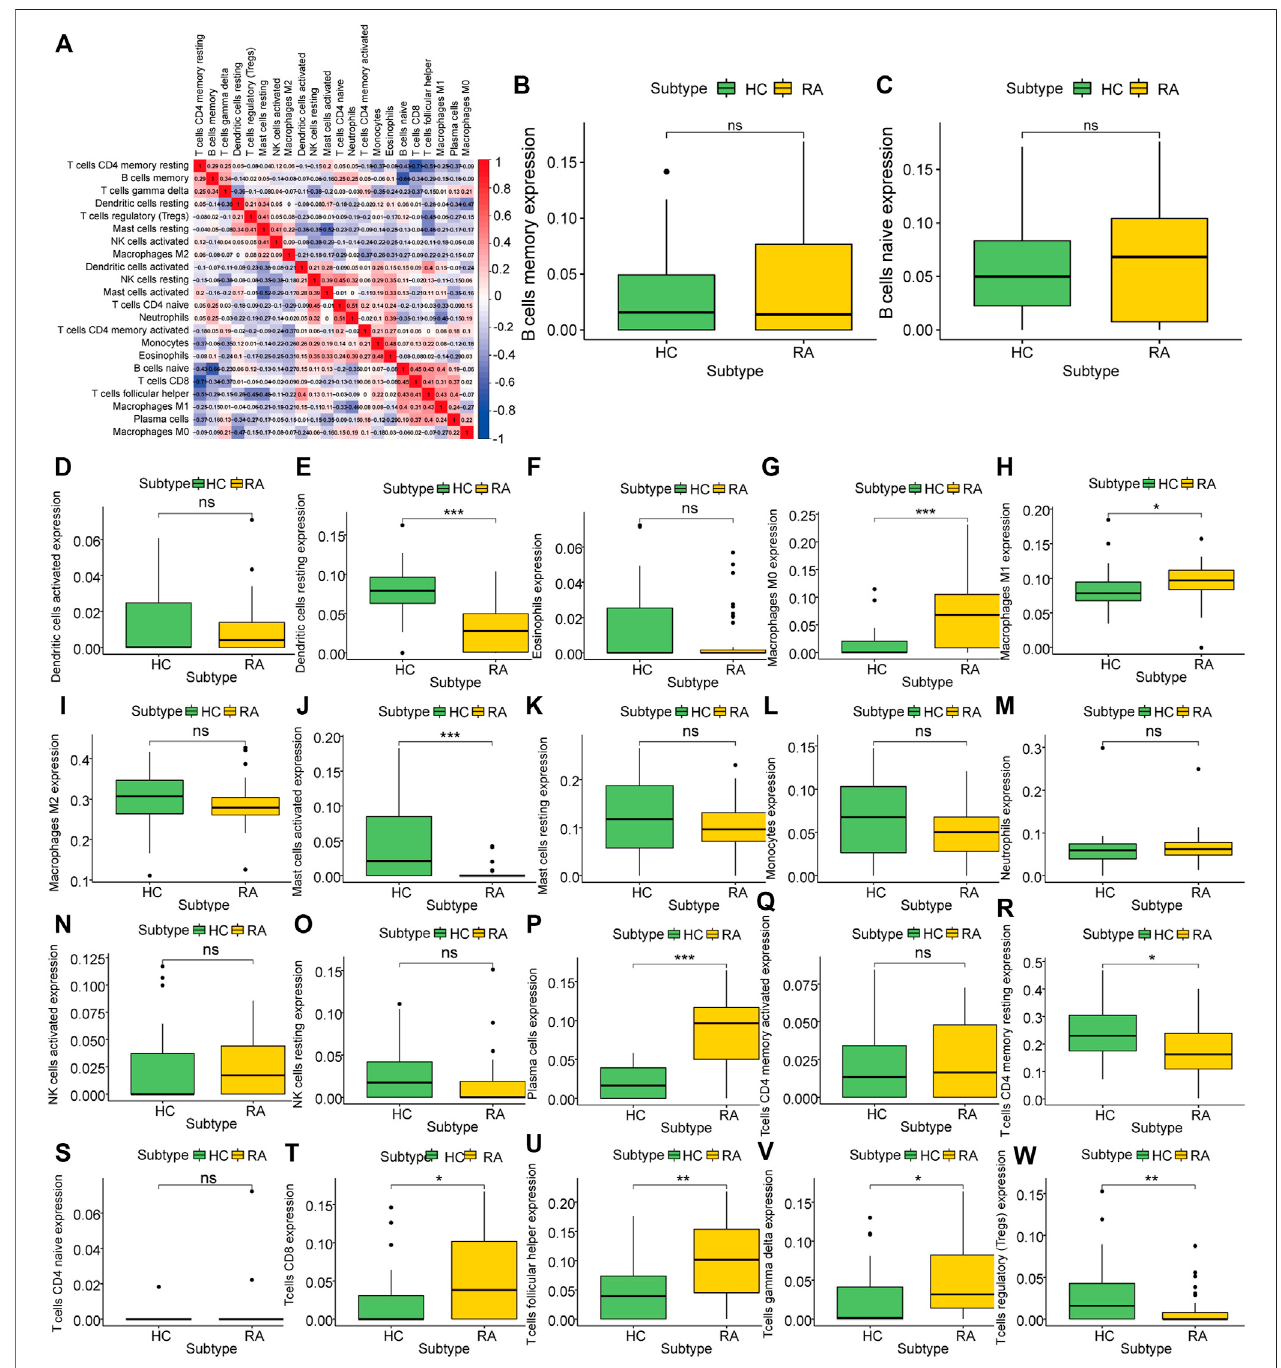
FIGURE 4 | Characteristics of Rheumatoid Arthritis Immune In fi ltration. (A) : Correlation of in fi ltration degree of 22 kinds of immune cell in synovial tissue, (B – W) : Difference analysis of immune cell in fi ltration degree between synovial tissue and normal tissue in rheumatoid arthritis.